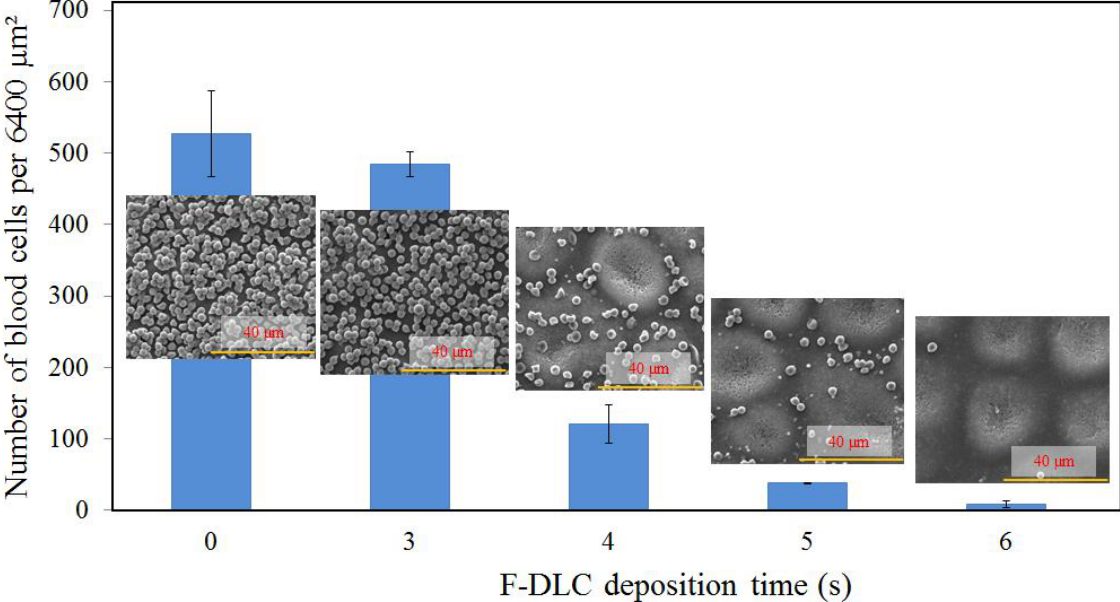
Figure 6. The amount of blood cells adhered on the membrane